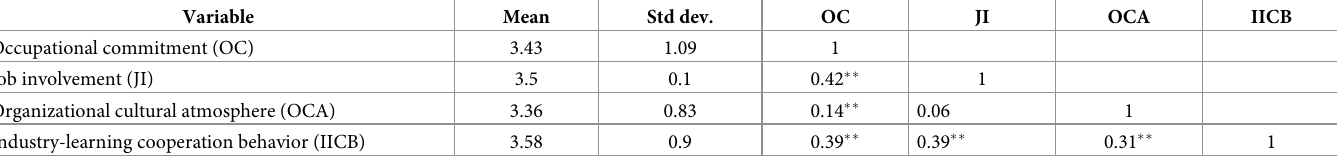
Table 4. Mean value, standard deviation and correlation coefficient of